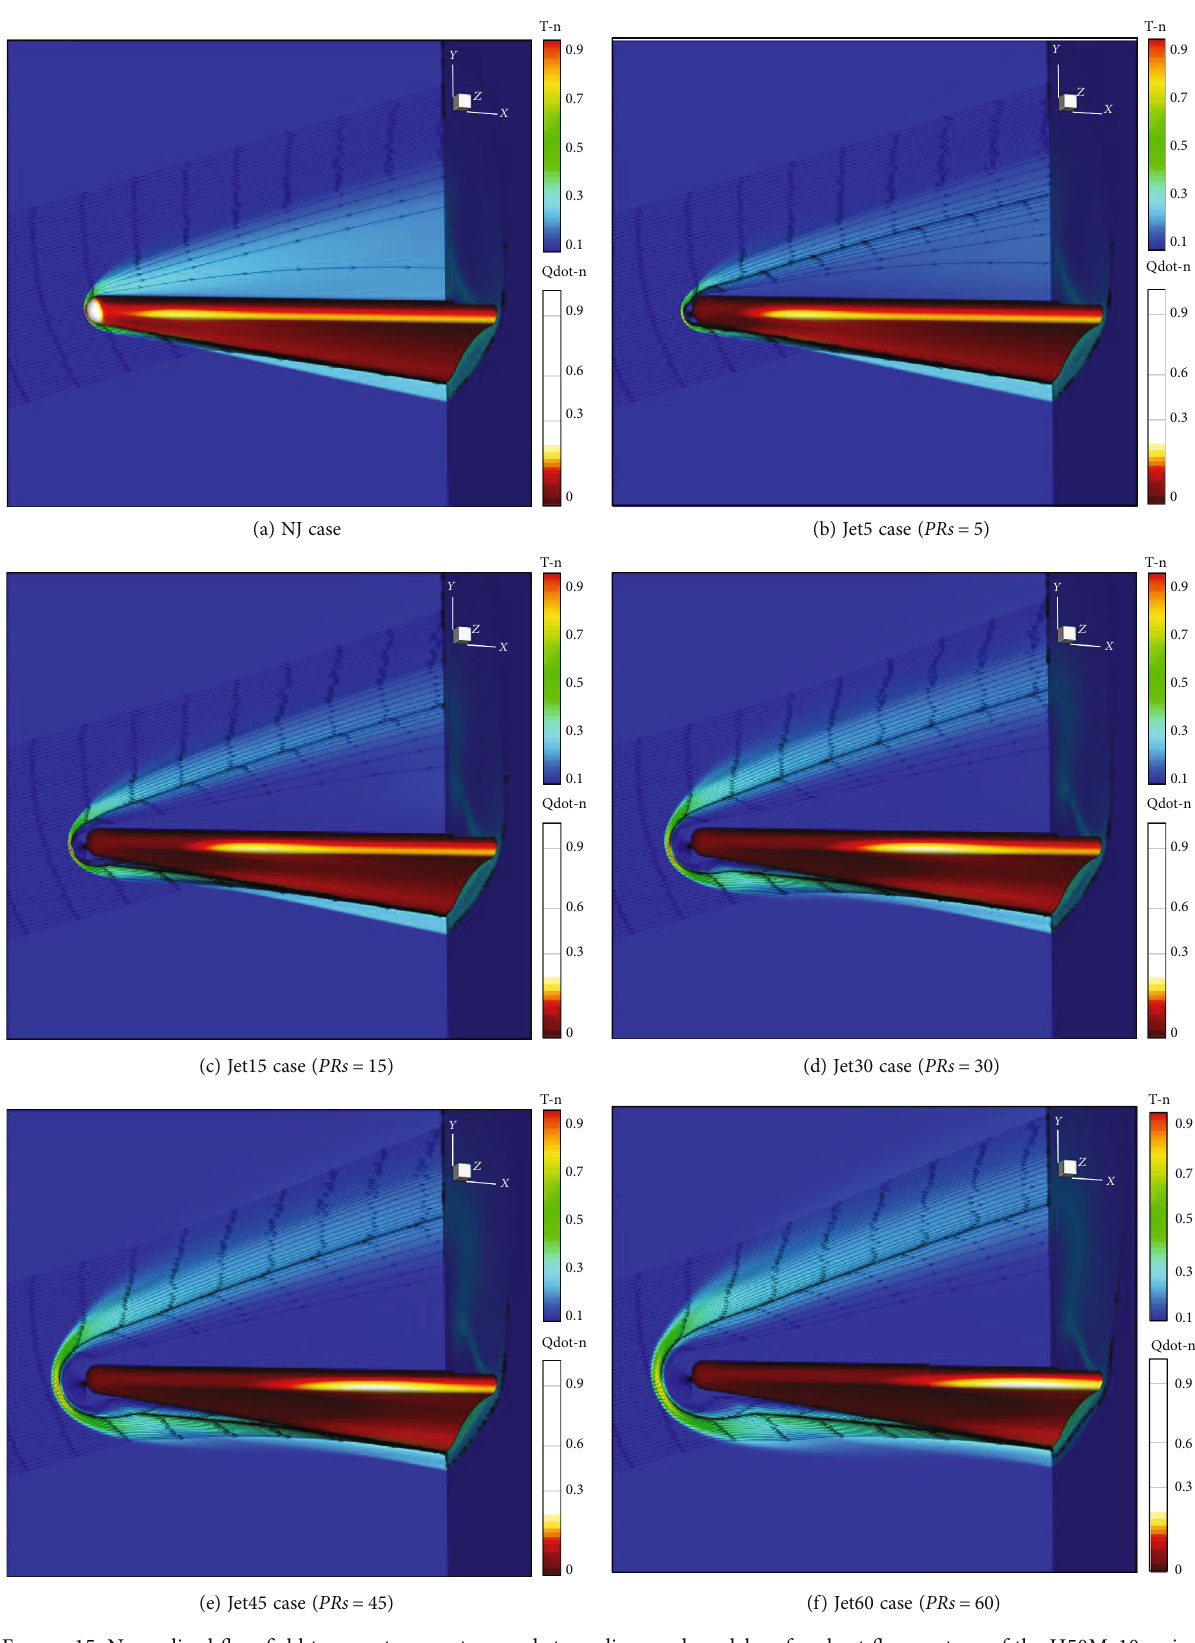
Figure 15: Normalized fl ow fi eld temperature contour and streamlines and model surface heat fl ux contour of the H50Ma10